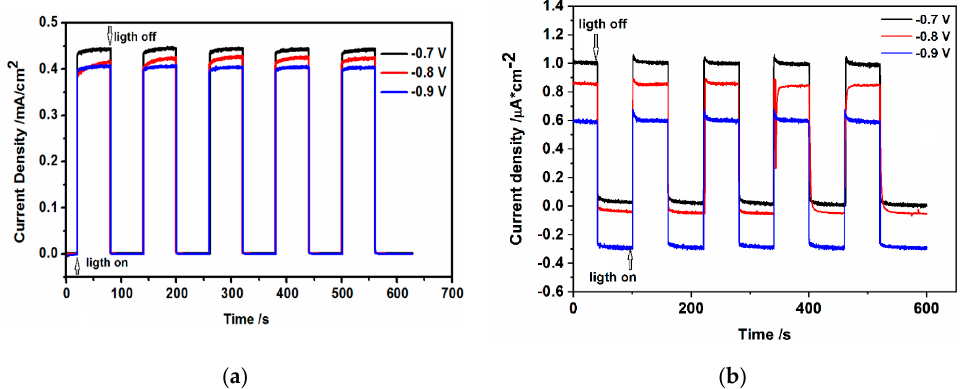
Figure 11. The changes of current densities during illumination at constant potentials of ( a ) CdS hydrophilic drop-cast nanoparticles ( b ) L-B layers (50 layers) of hydrophobic CdS nanoparticles deposited on ITO in 0.2 M Na 2 SO 3 /0.1 M Na 2 SO 4 .